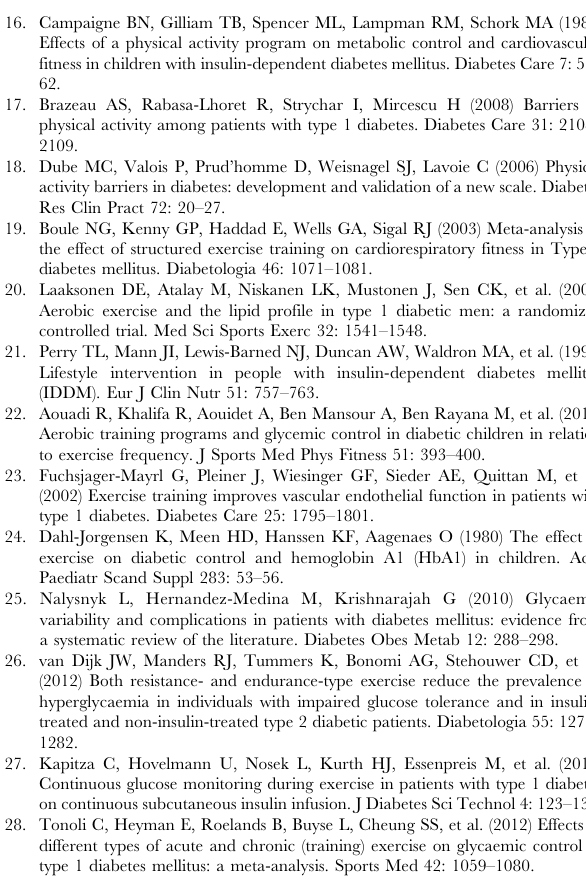
Figure S1 Funnel plot testing for publication